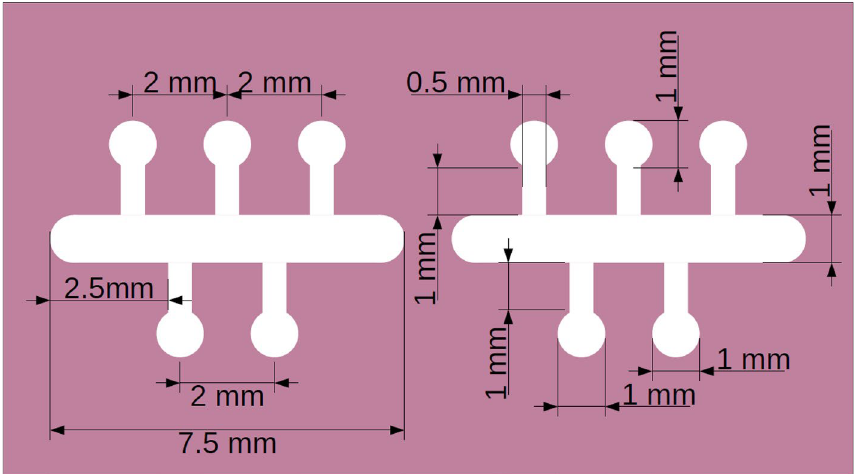
Figure 1. Evaporation mask used to deposit Cu films onto freshly cleaved